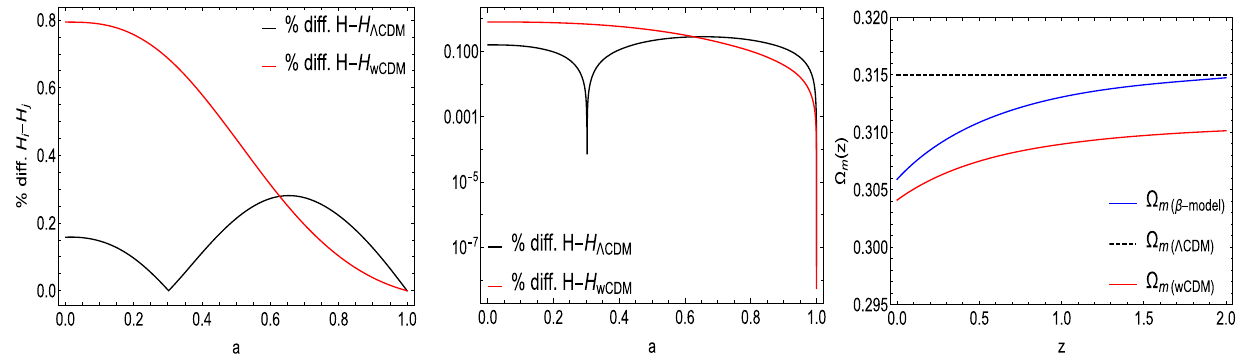
Fig. 4 The percentage relative difference %diff ( H i − H j ) in linear (left panel) and logarithm (central panel) scales between the β -model, Λ CDM and w CDM models for their mean values as shown in Table 3. In the right panel, it is also shown Om(z)